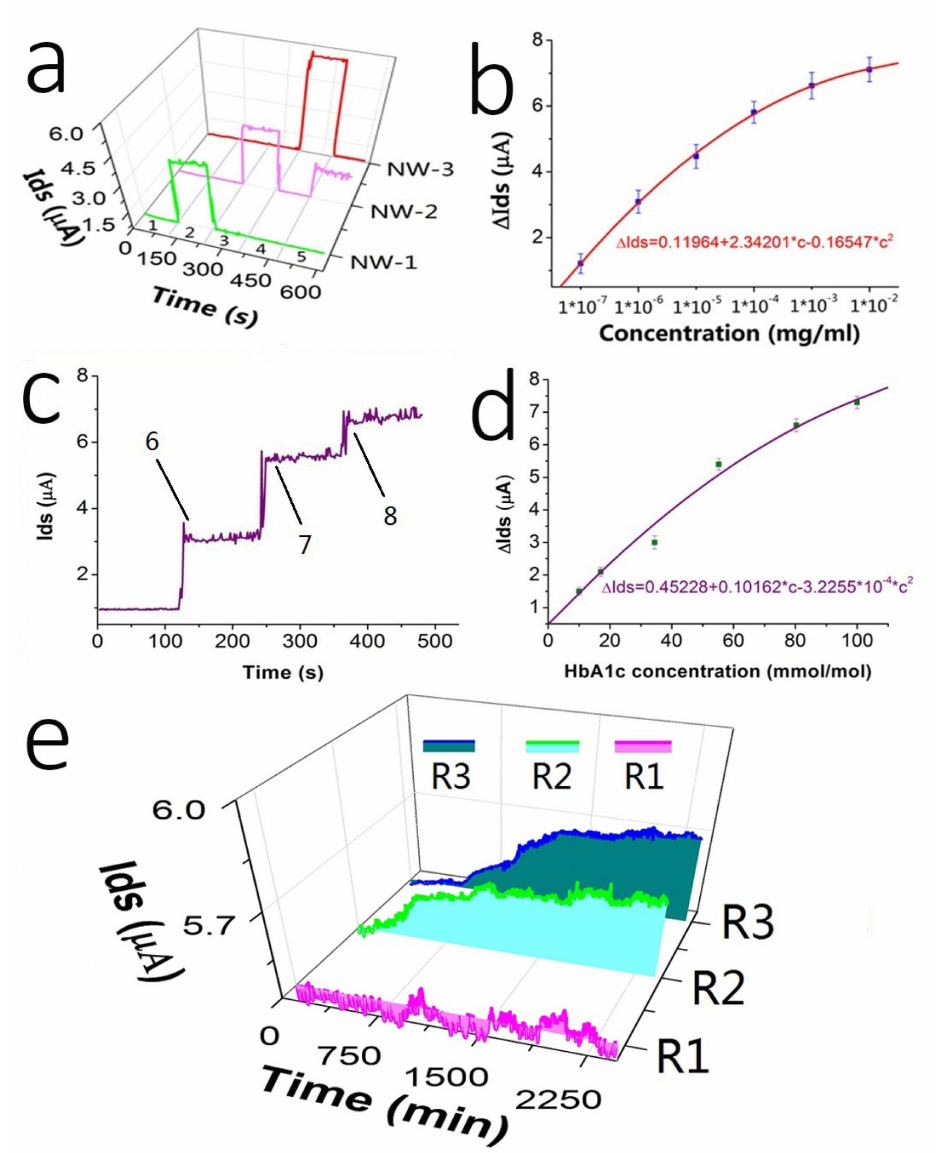
Figure 5. Experiment results of the detection application of SiNW-FET. ∆ Ids is represented by x ± SD, c represents concentration. ( a ) Specific detection result of the sensor, NW-1, NW-2, and NW-3 modified anti-GA, anti-HbA1c, and anti-BSA, respectively. They were detected in the following sequence: (1) 0.02 × PBS, (2) glycated albumin (GA) standard 5 ng/mL, (3) HbA1c standard 5 ng/mL, (4) bovine serum albumin (BSA) standard 5 ng/mL, and (5) HbA1c standard 0.5 ng/mL. ( b ) Results of current changes corresponding to different concentrations of the HbA1c standard. ( c ) Detection results of HbA1c in rabbit blood; the concentrations of HbA1c represented by 6, 7, and 8 were 34.43 mmol/mol, 55.19 mmol/mol, and 80.33 mmol/mol, respectively. ( d ) Results of current changes corresponding to different concentrations of HbA1c in rabbit blood. ( e ) Dynamic detection results of